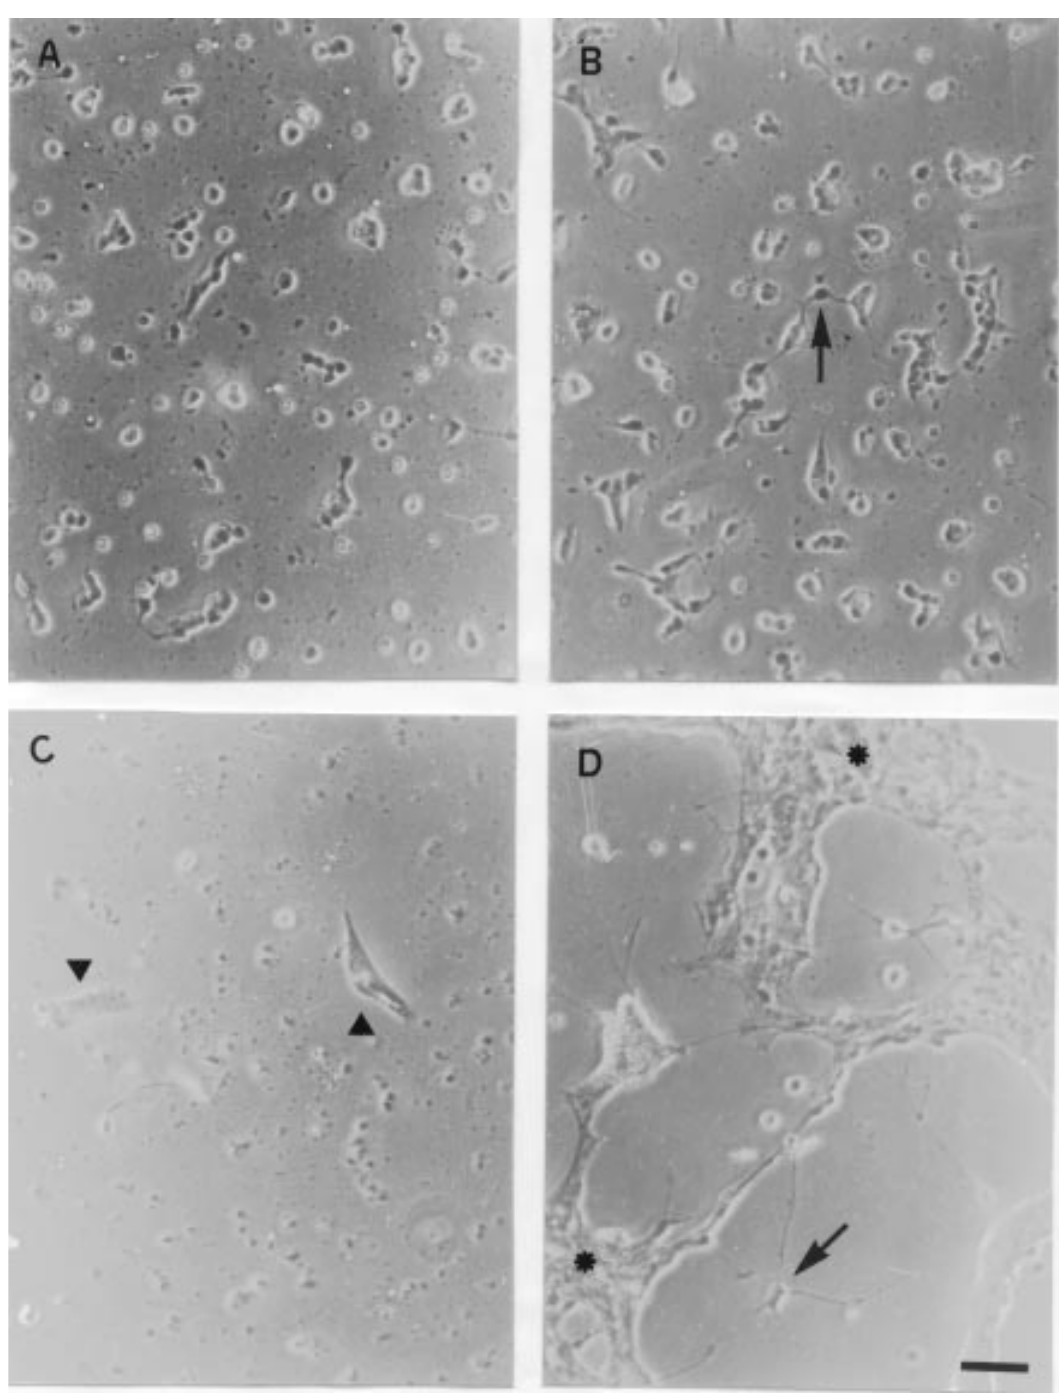
Figure 1 - Phase contrast photomicrographs of retinal cells in vitro . Cells were dissociated from neonatal rat retina and cultured for 48 (A and B) and 120 h (C and D). A and C , Control cultures; B and D , cultures maintained in the presence of conditioned medium (1:10). The plating density was 1.3 x 10 6 cells/dish. Note the presence of isolated neuronal cells with long neurites (arrows) and flat-shaped glial cells (arrowheads) in the cultures. Extensive clusters of neuronal and glial cells are indicated by asterisks. Magnification bar for all photomicrographs: 50